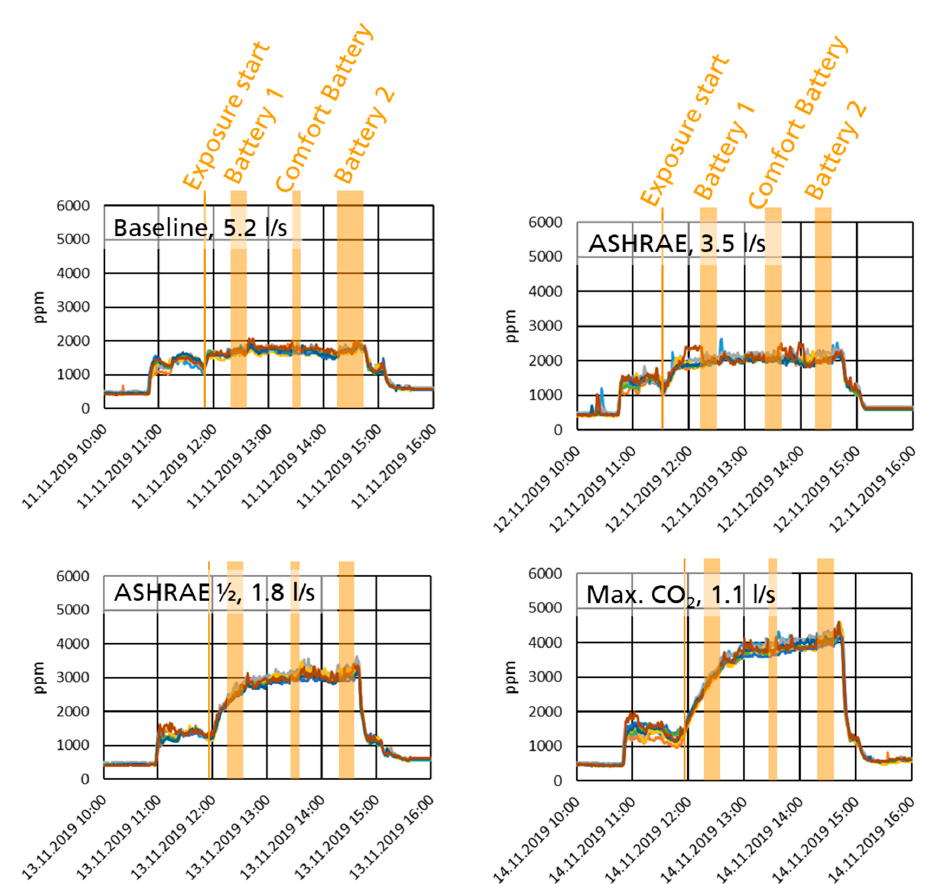
Figure 11. Measured average CO 2 concentration in the cabin (pressure corrected).